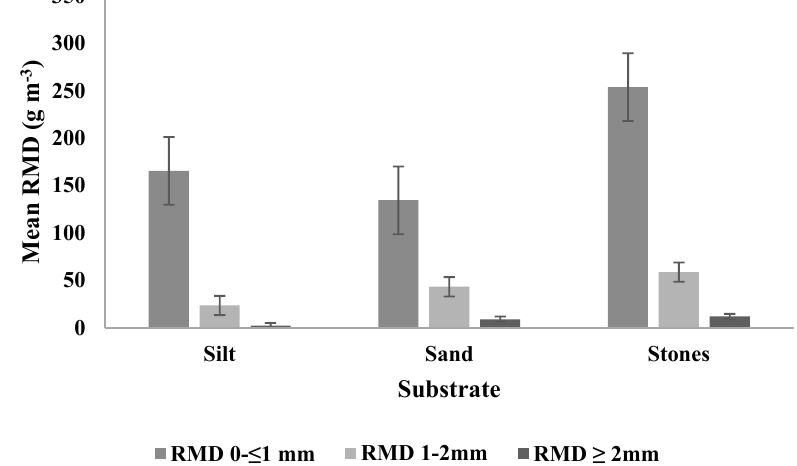
Figure 4. Mean root mass density (RMD) separated by diameter class and substrate. Error bars are 1 SE.